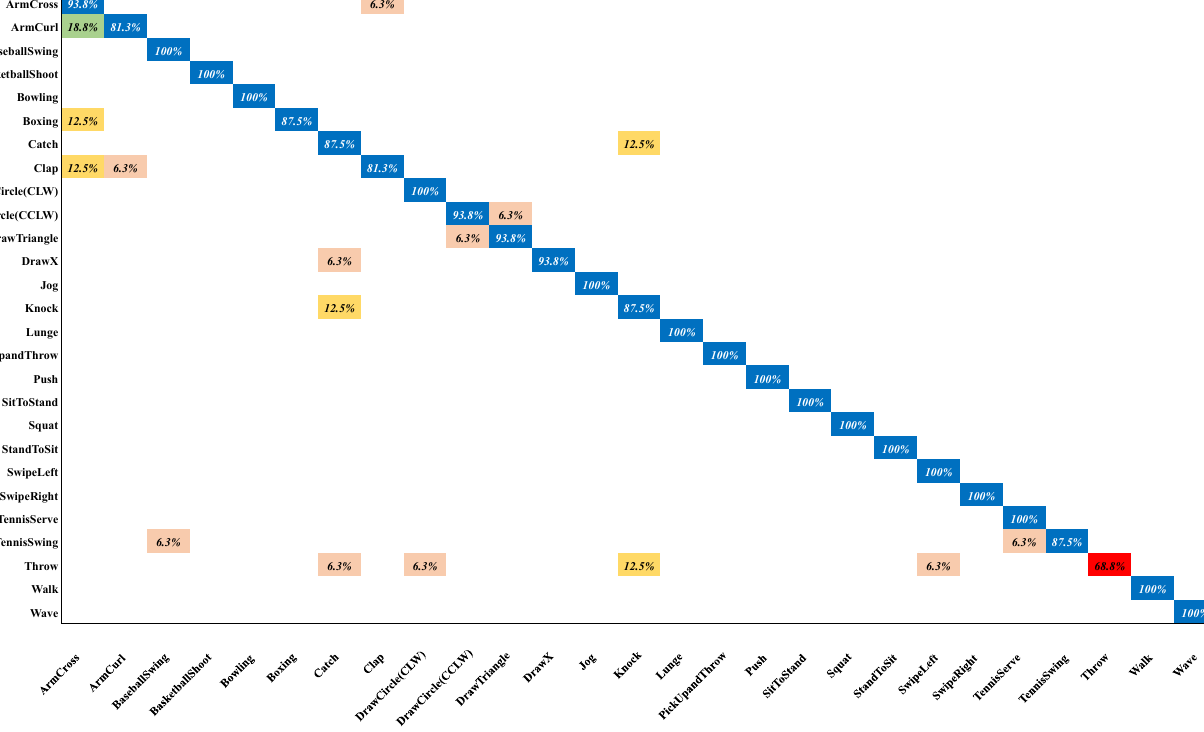
Figure 10. Confusion chart of UTD-MHAD dataset (best results with SSIM, k = 24).